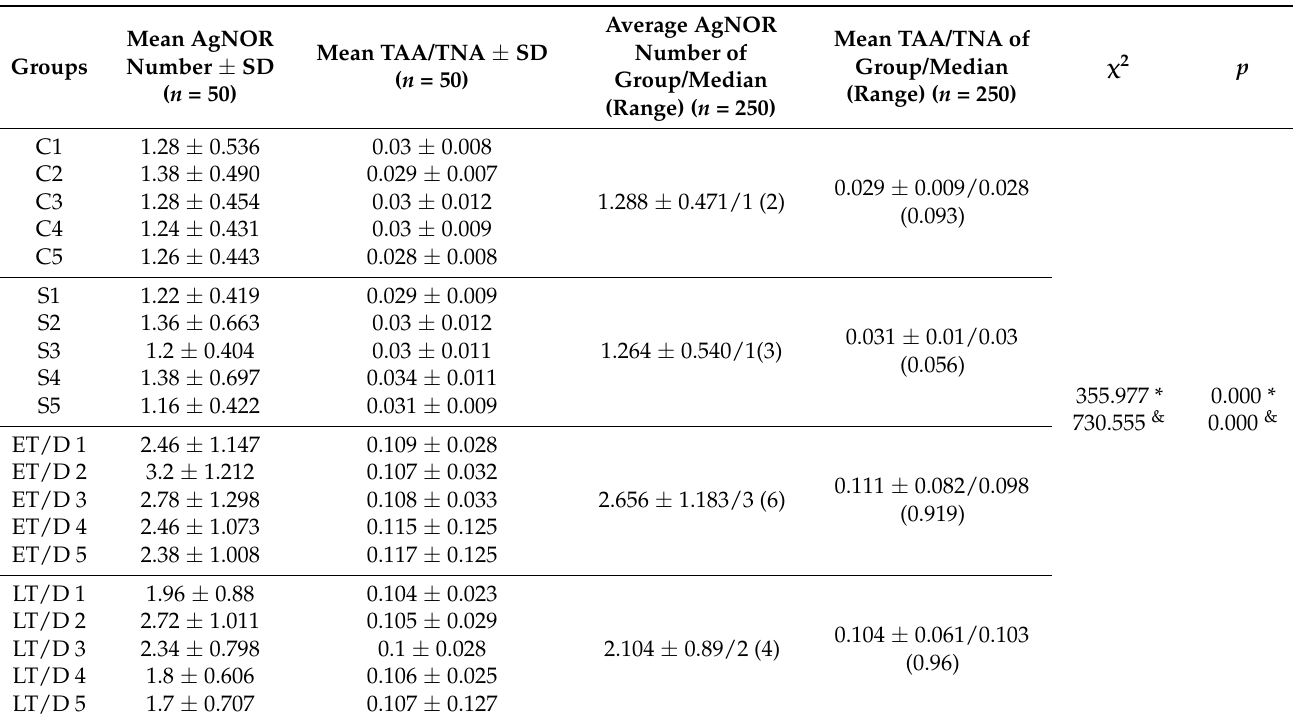
Table 1. Mean AgNOR number and TAA/TNA ratio of each subgroup, average AgNOR number of group and average TAA/TNA ratio of these groups.